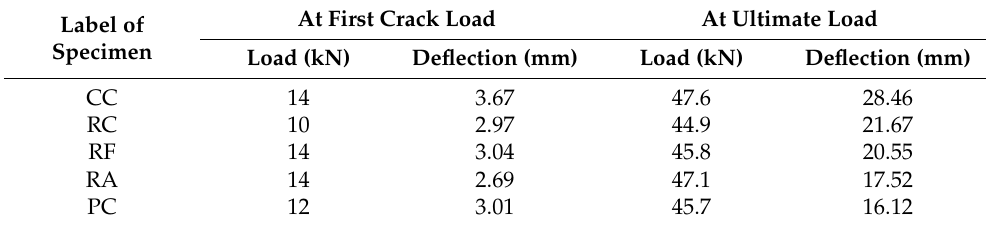
Table 5. Deflection of beam specimens.